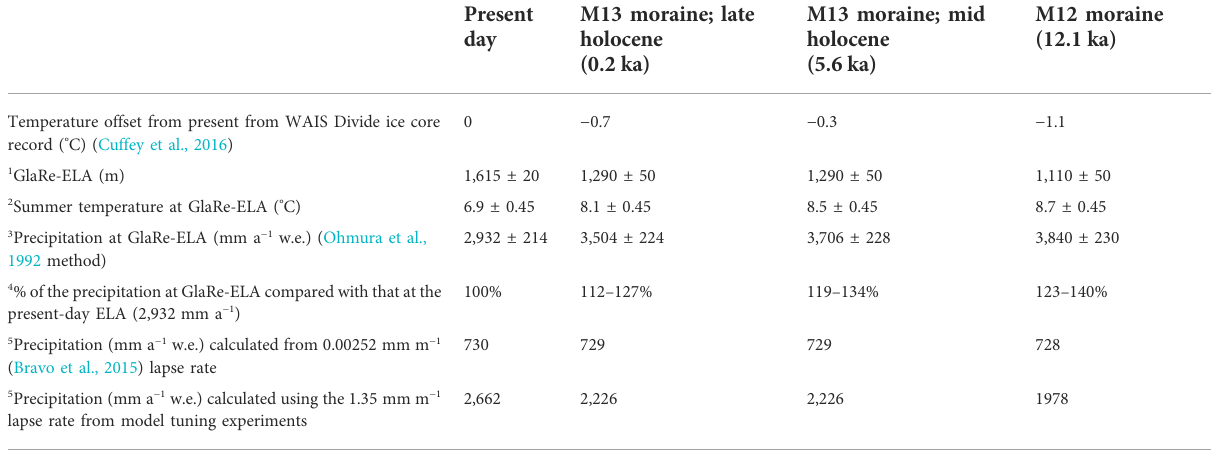
TABLE 5 1 GlaRe-ELAs, rounded to the nearest 5 m, and the 2 temperature and 3 precipitation reconstructed at the GlaRe-ELA for the year 2010 glacier extent andforthe M12andM13moraines. 4 The percentagedifferenceinprecipitationatthe GlaRe-ELAwhen comparedwithprecipitationatthe present-day GlaRe-ELA. 5 The precipitation at each altitude is independently calculated using two precipitation lapse rates and precipitation data from Cochrane weather